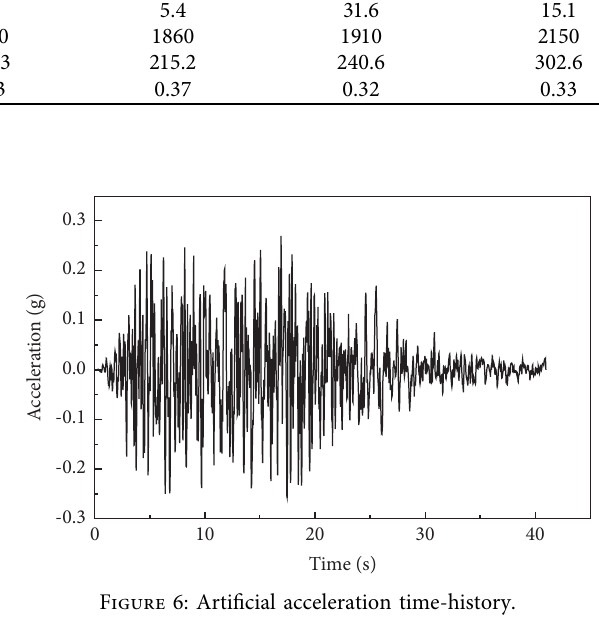
Figure 6: Artificial acceleration time-history.